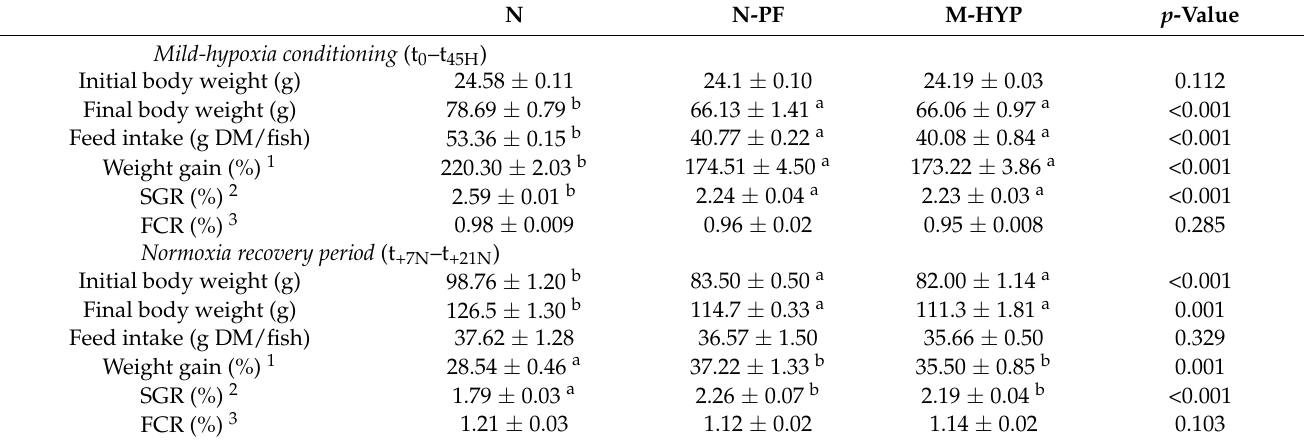
Table 1. Effects of mild-hypoxia conditioning on the growth performance of gilthead sea bream juveniles in a 45-day trial followed by a normoxia recovery period of 21 days. Values are the mean ± SEM of triplicate tanks. The p -values are the result of one-way ANOVA. Different superscript letters indicate significant differences between the experimental groups (SNK test, p < 0.05).